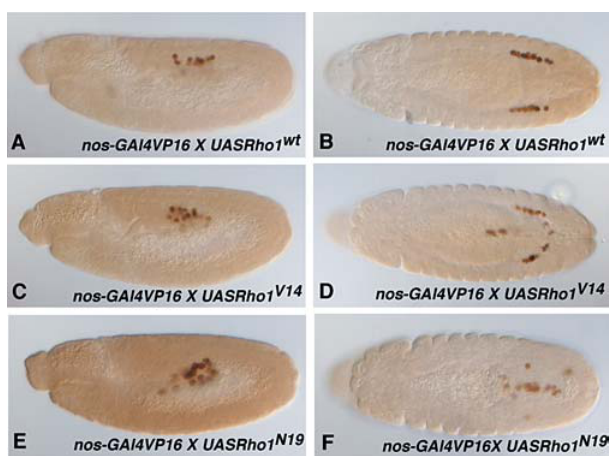
Figure 8. Rho GTPase Is Required for Transepithelial Migration of Germ Cells (A–F) Wild-type, constitutively active, and dominant-negative Rho1 constructs under UAS promoter control were expressed in germ cells using the nos-GAL4 driver. Embryos are stained with anti-Vasa (brown) to mark germ cells. Anterior is left. Embryos in (A), (C), and (E) are lateral views at stage 11. Embryos in (B), (D), and (F) are top views, stage 13. (A and B) Germ cells expressing wild-type Rho1 ( Rho1 wt ) migrate normally. (C and D) Germ cells expressing constitutively active Rho1 ( Rho1 V14 ) successfully transmigrated the PMG (C), but some germ cells fail to move from the PMG into the mesoderm and remain associated with the PMG (D). (E and F) Germ cells expressing dominant-negative Rho1 ( Rho1 N19 ) are still inside the PMG at stage 11 (E), and most germ cells remain ‘‘ clumped ’’ inside the gut (F). DOI: